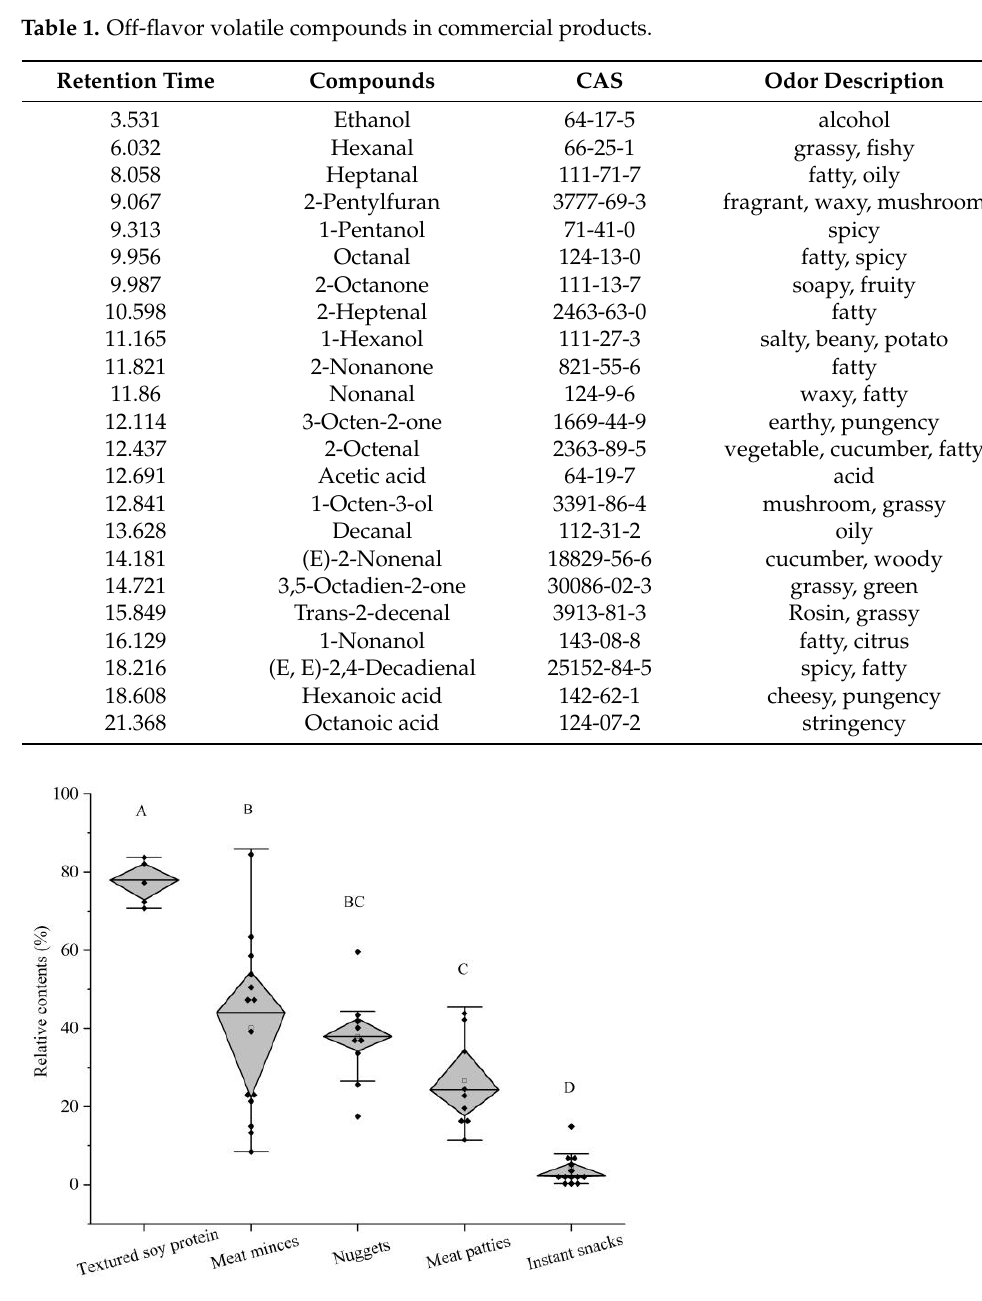
Figure 2. The total relative contents of off-flavors in raw commercial plant-based analog products. Different capital letters indicate significant differences (α = 0.05 level).